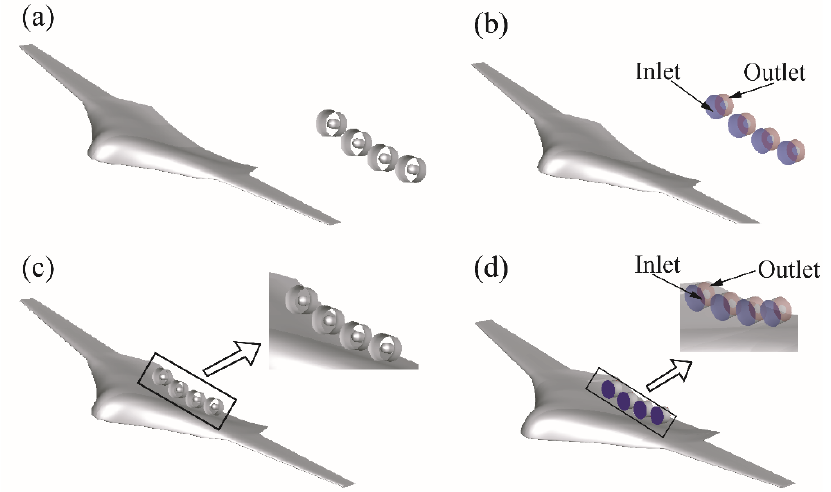
Figure 10. Simplified models of DPD for the analysis of aerodynamic power consumption. ( a ) Noninstalled through-flow model A1; ( b ) Noninstalled with powered fans model A2; ( c ) Mounted through ‐ flow model B1; ( d ) Mounted with powered fans model B2.